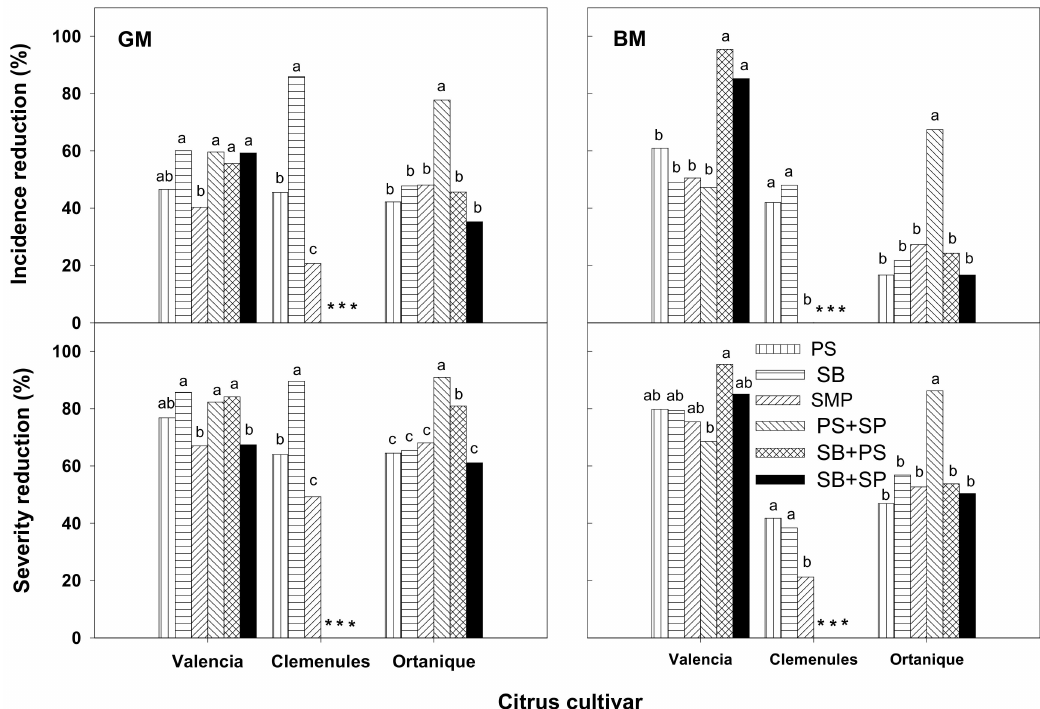
Figure 4. Curative activity of hydroxypropyl methylcellulose (HPMC)-lipid edible composite coatings, containing potassium sorbate (PS), sodium benzoate (SB), sodium propionate (SP), sodium methylparaben (SMP), or a mixture of these, against green (GM) and blue (BM) molds on different citrus cultivars artificially inoculated with Penicillium digitatum and P. italicum , coated 24 h later, and incubated for 7 days at 20 ◦ C. Disease incidence and severity reductions were determined with respect to control fruit (inoculated but uncoated). For each mold and cultivar, columns with different letters are different by Fisher’s protected LSD test ( P < 0.05). * No data available. Reproduced from Palou et al. (2014) [58] with permission from the International Society for Horticultural